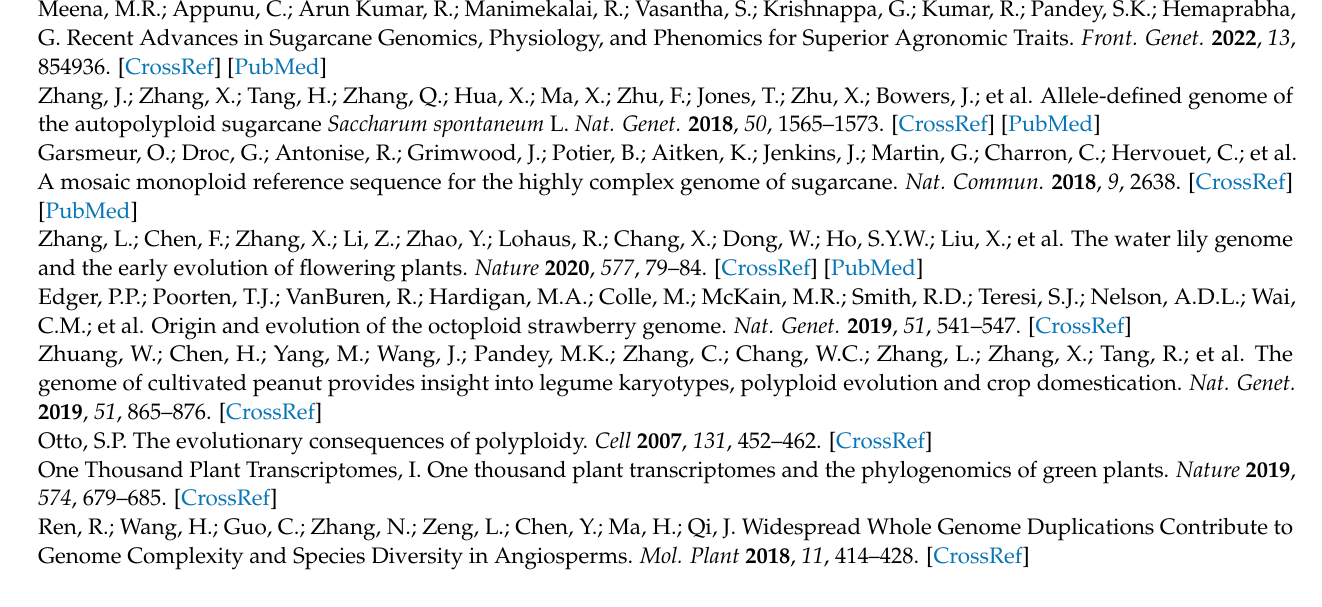
Table S3: GO enrichment analysis of dominant tetrad alleles; Table S4: GO enrichment analysis of suppressed tetrad alleles; Table S5: GO enrichment analysis of different DNA methylation association to dominant tetrad alleles; Table S6: GO enrichment analysis of different DNA methylation associ- ation to dominant tetrad alleles; Table S7: GO enrichment analysis of different DNA methylation association to suppressed tetrad